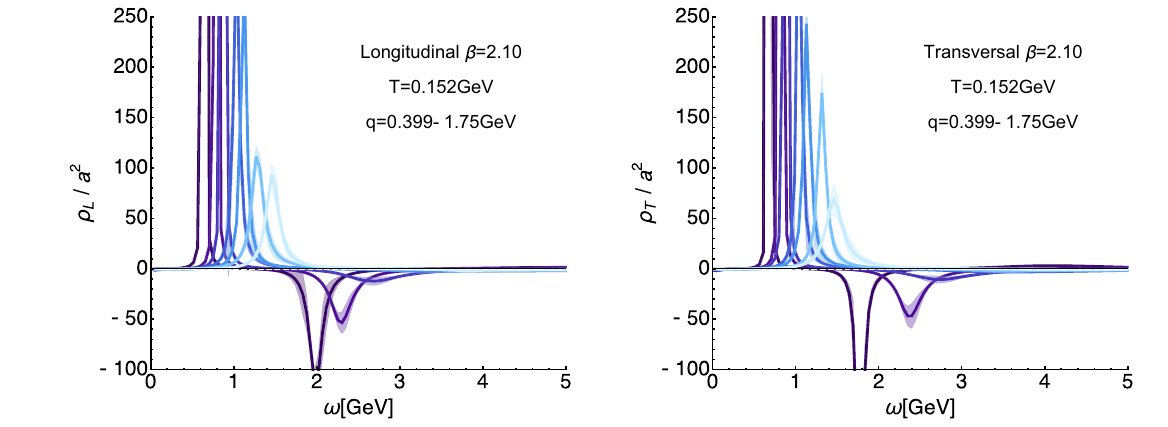
Fig. 7 Reconstructed longitudinal (left) and transversal (right) gluon spectra on the β = 2 . 10 (top) ensemble at the lowest available temper- ature T = 0 . 152 GeV. The different curves denote a subset of spatial momenta at which correlator data is available. The y -axis is cut off to